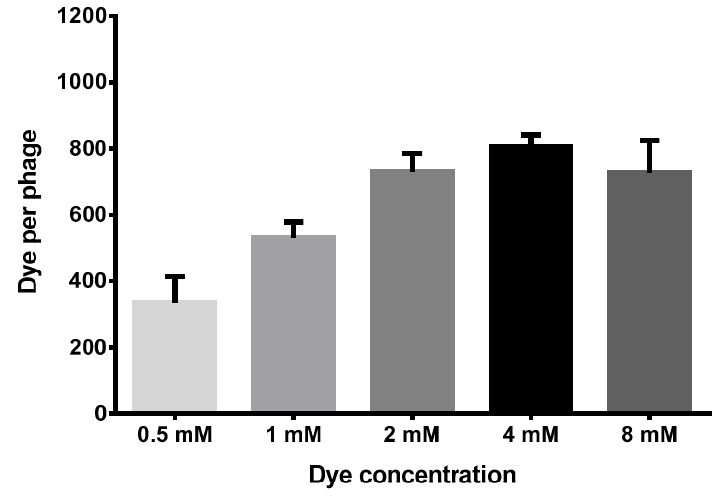
Figure 4. The dependence of FAM-NHS dye concentration on the modification coefficient. Note: FAM/phage is the modification coefficient of the bacteriophage coat protein by fluorescent dye.